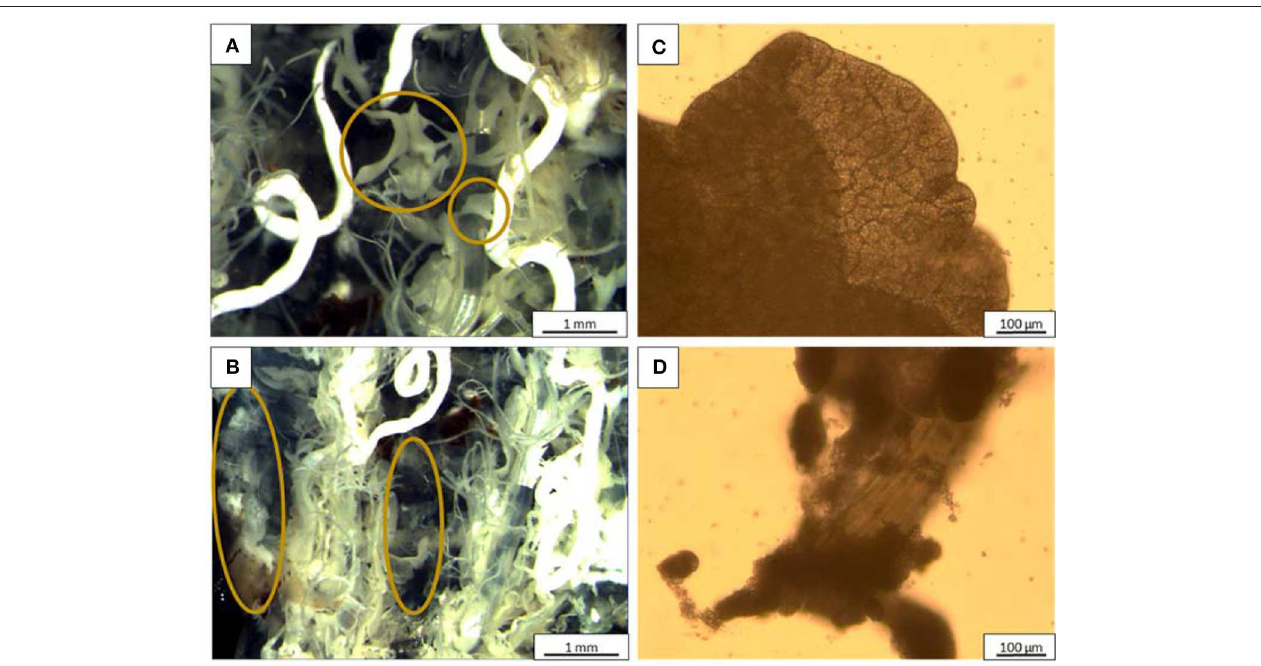
FIGURE 2 | Stereomicroscopy and light microscopy images, respectively, of (A,C) perivisceral fat body; (B,D) peripheral fat body. The organs encircled in (A,B) are, respectively, the perivisceral and peripheral